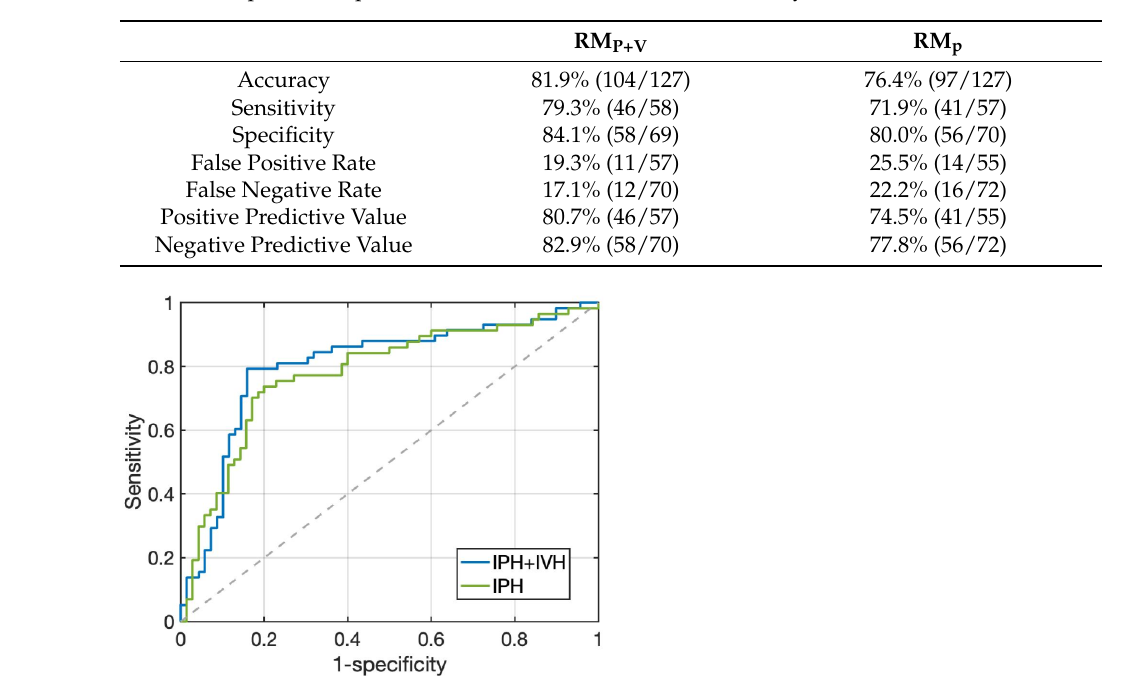
Table 2. The prediction performance of two different radiomics analysis models.